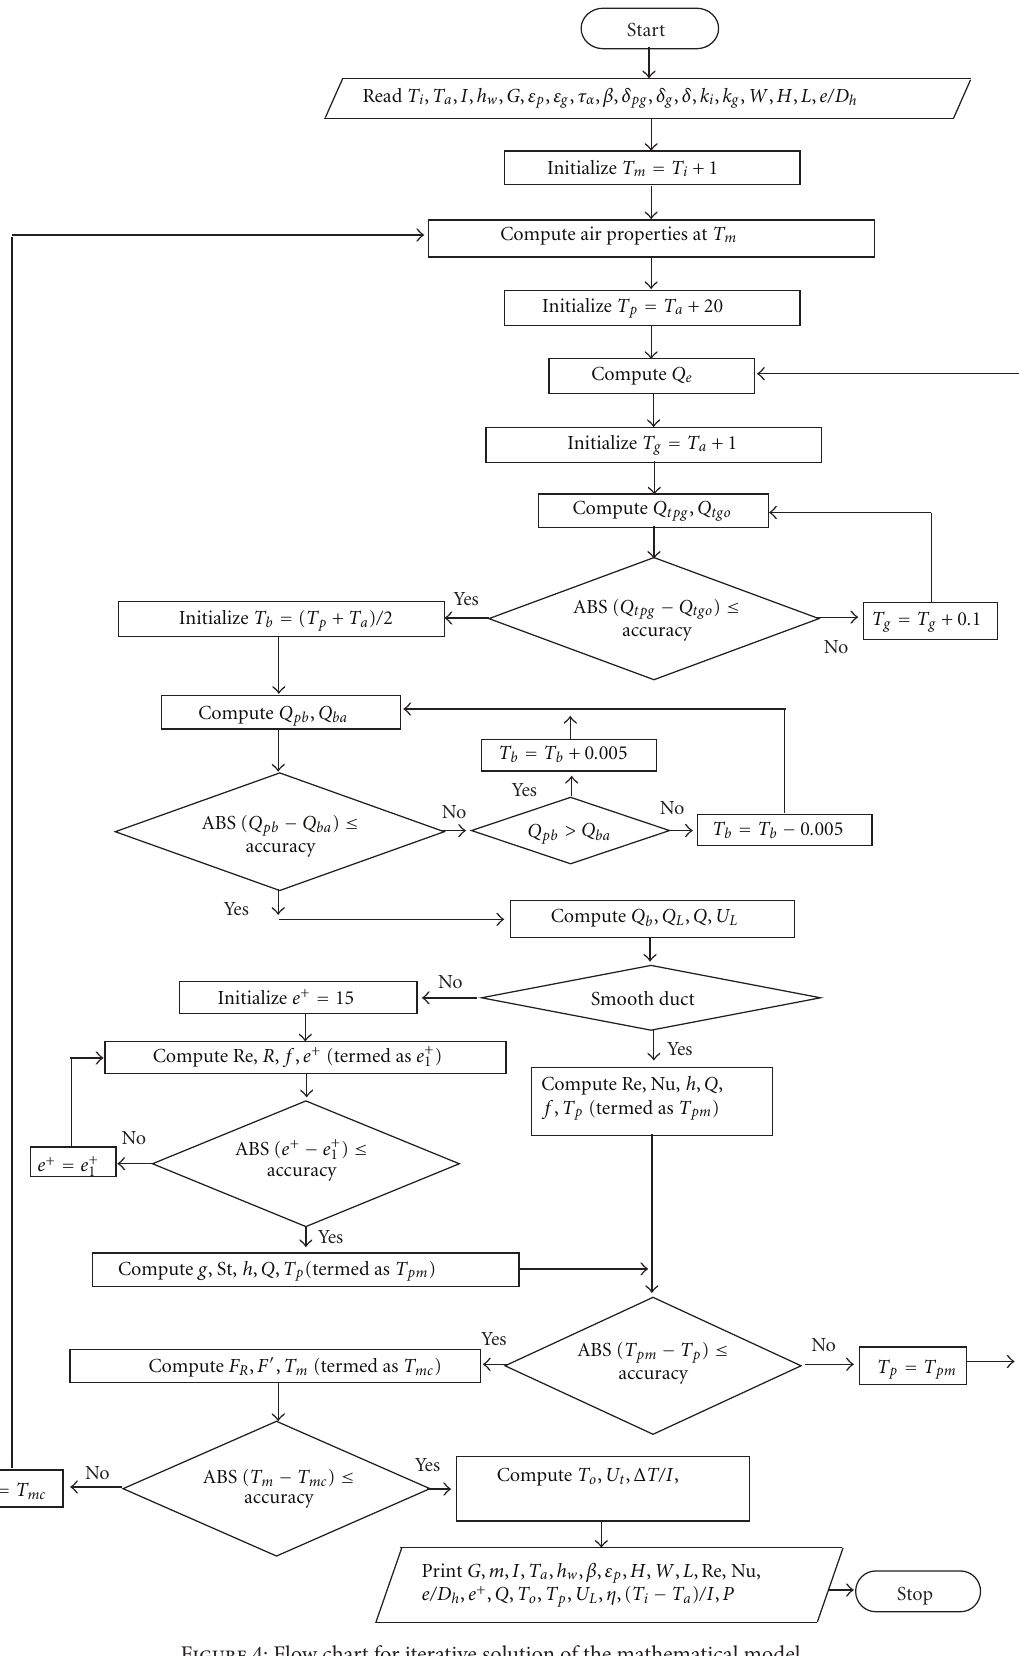
F 4: Flow chart for iterative solution of the mathematical